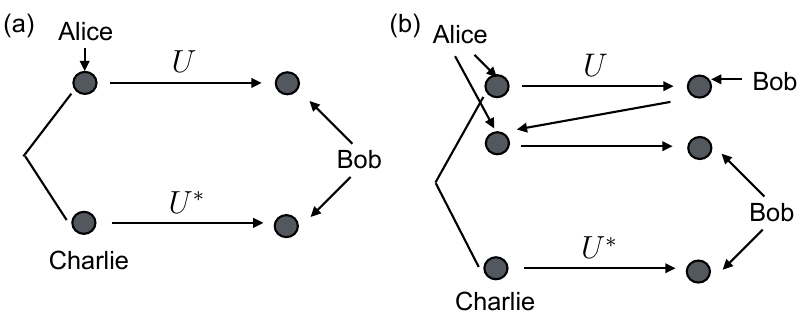
Figure 6 . Alice and Bob play a game of catch, and Alice modi(cid:12)es the ball with some nonzero probability. (a) Charlie throws an identical but unmodi(cid:12)ed ball to Bob. This represents an average of 4-point OTO correlation functions. (b) Bob throws the ball back to Alice who then throws it back to Bob. This represents an average of 8-point OTO correlaton